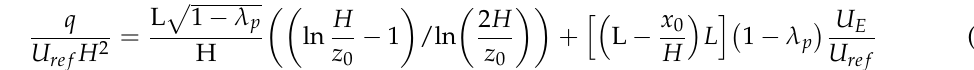
 ) and velocity in the canopy layer ( f ) and velocity in the canopy layer ( U C f